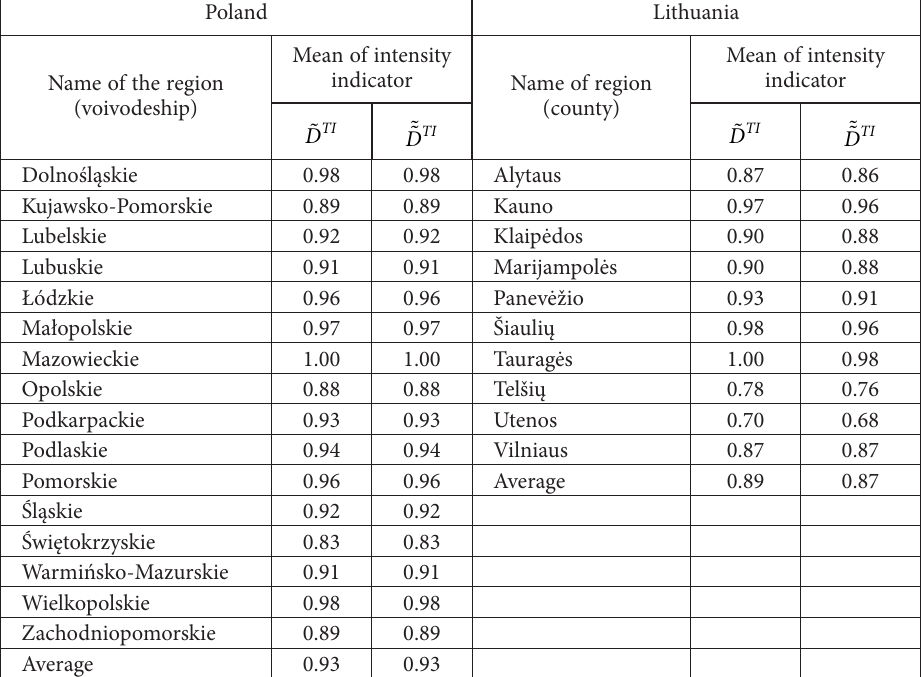
Table 4. The results of intensity calculation of economic development in Polish and Lithuanian regions 2008–2017 (source: compiled by